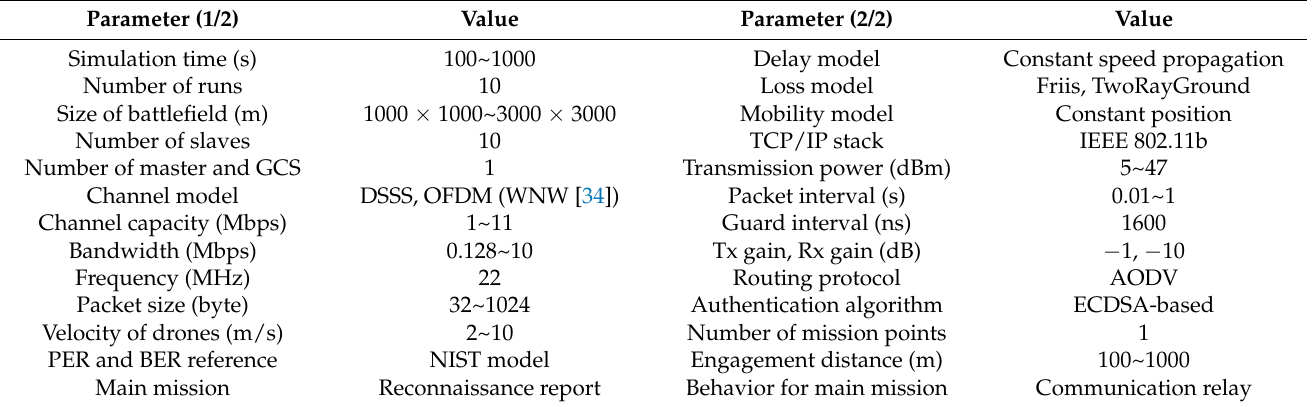
Table 1. D-CEWS (DEVS-based cyber-electronic warfare)-based communication and functional simula- tion parameters for reconnaissance report communication simulation of swarming drone